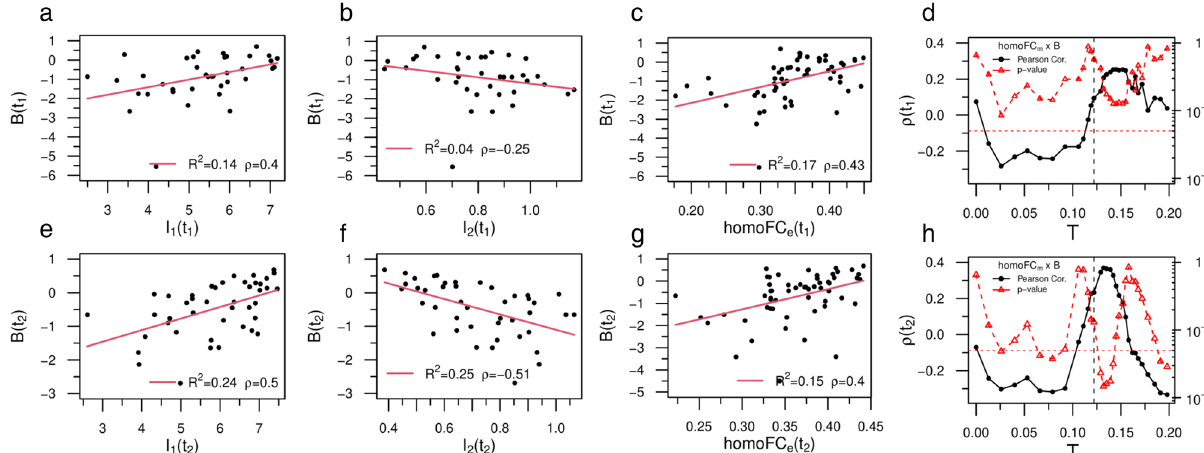
Fig. 6 Relationship between recovery of criticality, functional connectivity, and behavior. a , e Correlation between I 1 and behavior at t 1 and t 2 , respectively. The legend shows the (linear) correlation, ρ and the R 2 . b , f Same but for I 2 . The dynamical variables ( I 1 , I 2 ) predicted a signi fi cant amount of behavioral variance, higher at t 2 . c , g Correlation between empirical homotopic F C e and behavior at t 1 and t 2 , respectively. d , h Linear correlation between model homo-F C m and behavior for different values of the excitation threshold T . Near the critical point ( T c , black vertical lines) the stochastic model reproduces the positive correlation with behavior observed empirically (black dots) with a corresponding peak in the statistical signi fi cance (red triangles). Note the sharp increase in correlation as T nears the critical point and the subsequent fall of as T becomes subcritical. We added red horizontal lines at p = 0.05 for ease interpretation. All the p -values were Benjamini – Hochberg corrected for multiple comparisons with false discovery rate (FDR) of α = 0.05. The p -value reported in panel b did not remain signi fi cant after correcting. However, note the abnormal behavior of a single individual close to B ( t 1 ) ~ − 6. Removing this outlier from the analysis we obtain ρ = − 0.42 with p -value < 0.05. See Supplementary Table 2 for accessing the sample size and the signi fi cance for all the tests. The (two-tailed) p -values reported in panels ( d , h ) were not corrected for multiple comparisons. Source data are provided as a Source Data fi